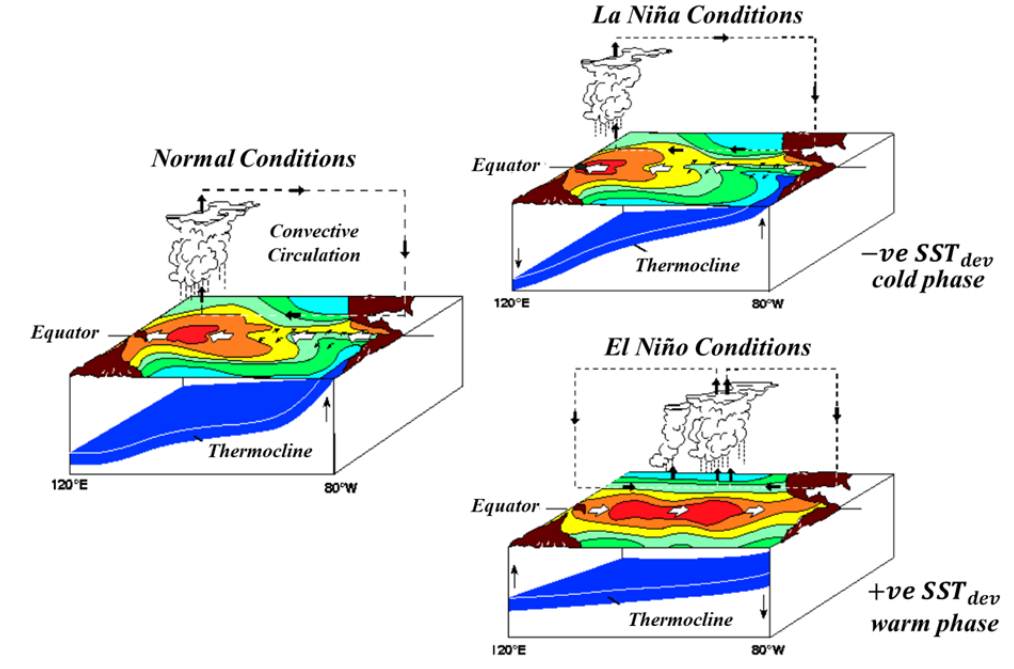
Figure 13. El Niño–Southern Oscillation (ENSO)